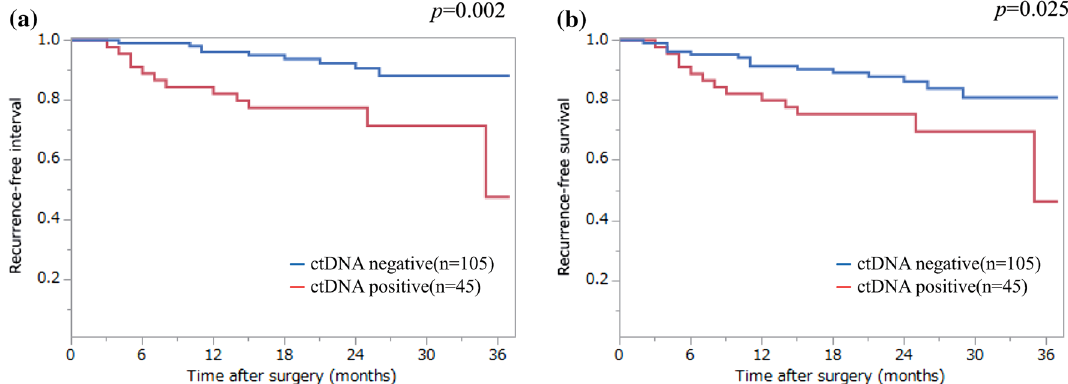
Figure 2. Kaplan–Meier analysis of recurrence-free interval ( a ), and recurrence-free survival ( b ), according to preoperative KRAS status in ctDNA.